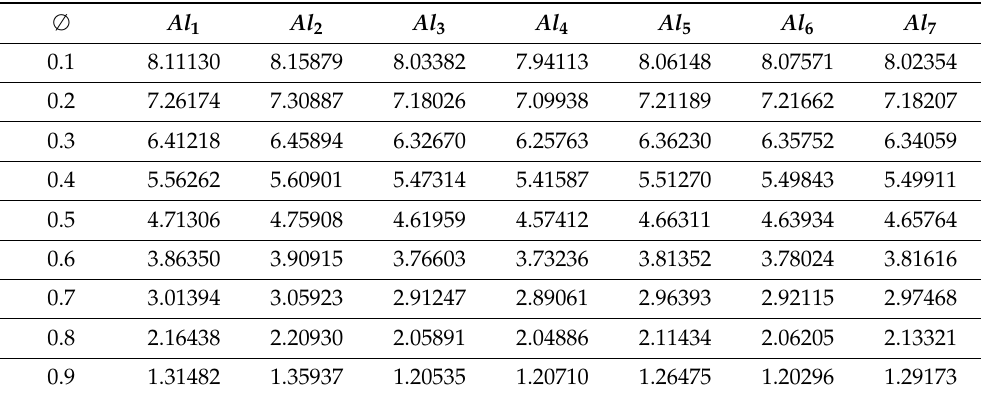
Table 15. Impact of ∅ on final ranking